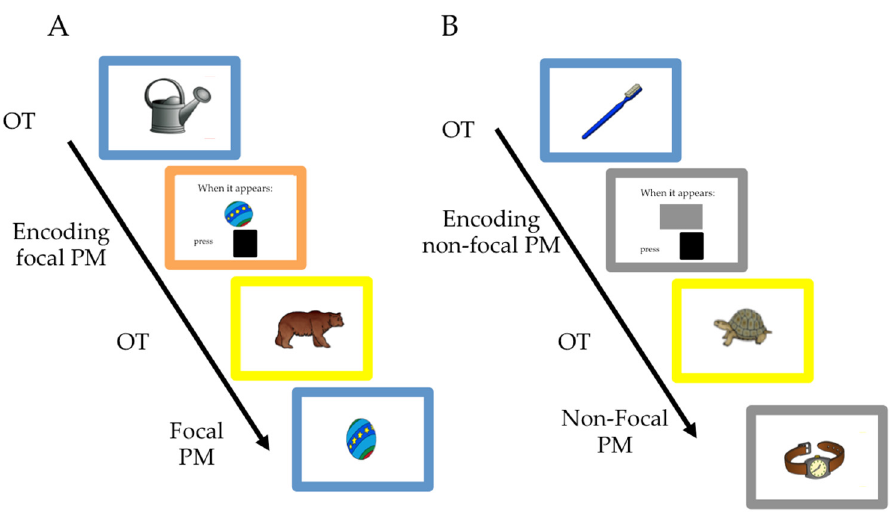
Figure 1. Schematic representation of the experimental paradigm used in the present study. The sequence consisted of practising the ongoing task (OT) and encoding the prospective memory (PM) intention. After the encoding part, participants performed an ongoing block where focal or non-focal PM trials were interweaved. ( A ) Example of a trial sequence for the focal block. ( B ) Example of a trial sequence for the non-focal block.